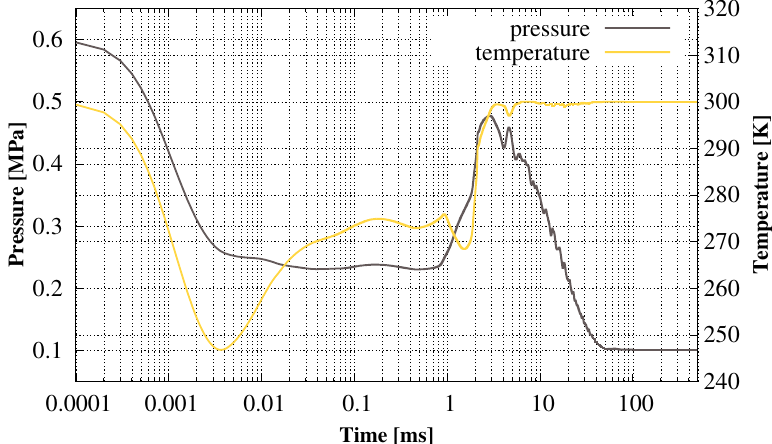
Figure 13. Inlet pressure and temperature time